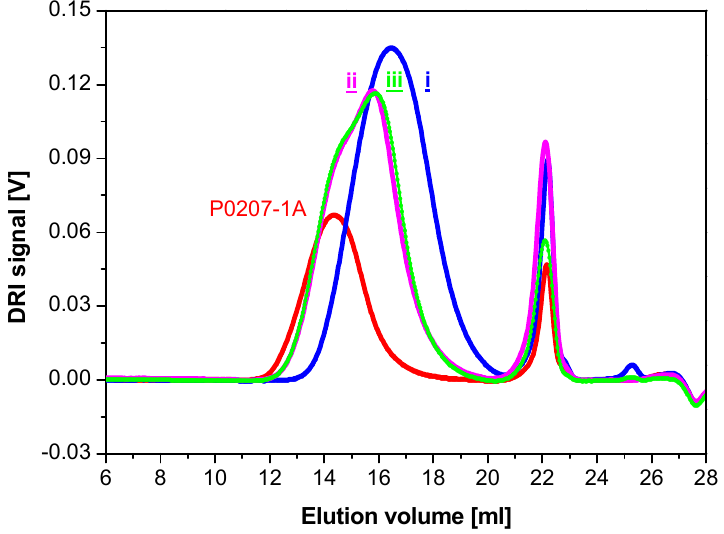
Figure 3. Superimposition of DRI signal (analyte concentration) of four